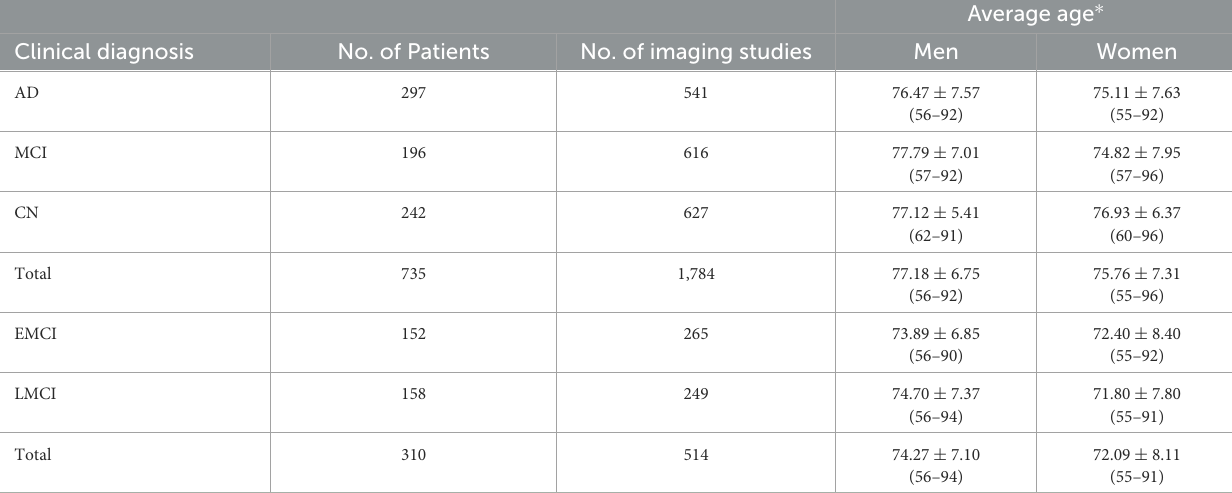
TABLE 1 Demographics of datasets.